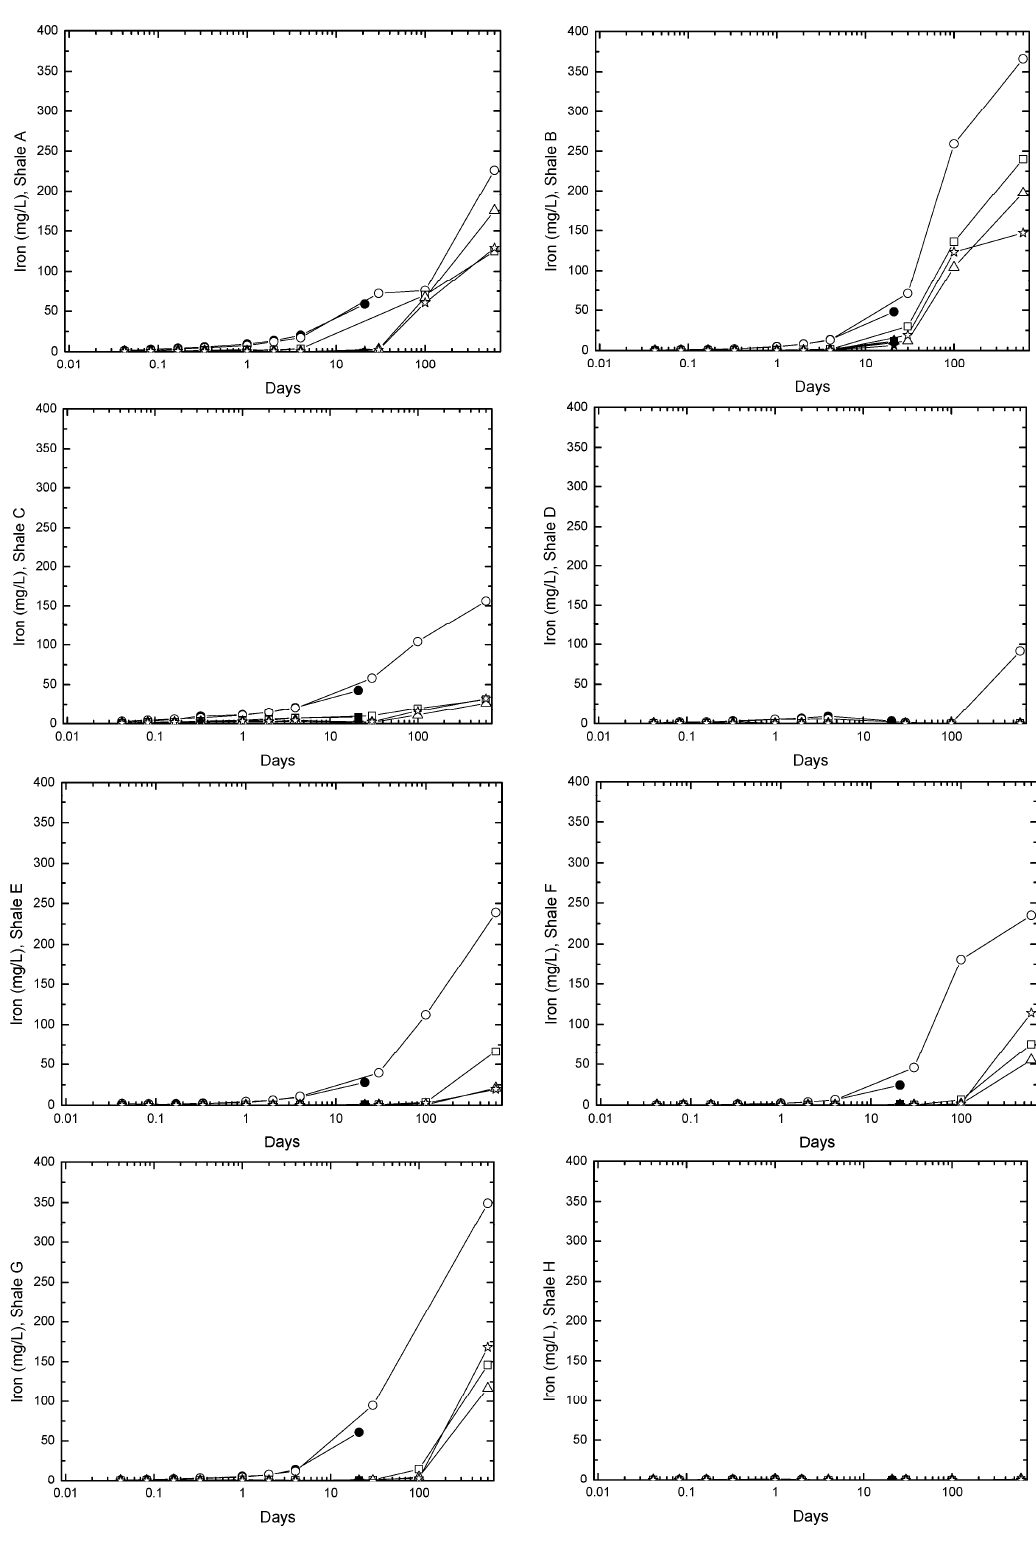
Figure 4. Solution Iron concentration recorded over time for all reaction vessels for all samples. Points on lines mark sample intervals from experiment commencement and 1, 2, 3, and 8 h, and 1, 2, 4, 21, 30, 100 and 600 days (logarithmic scale). The legend indicates initial sample